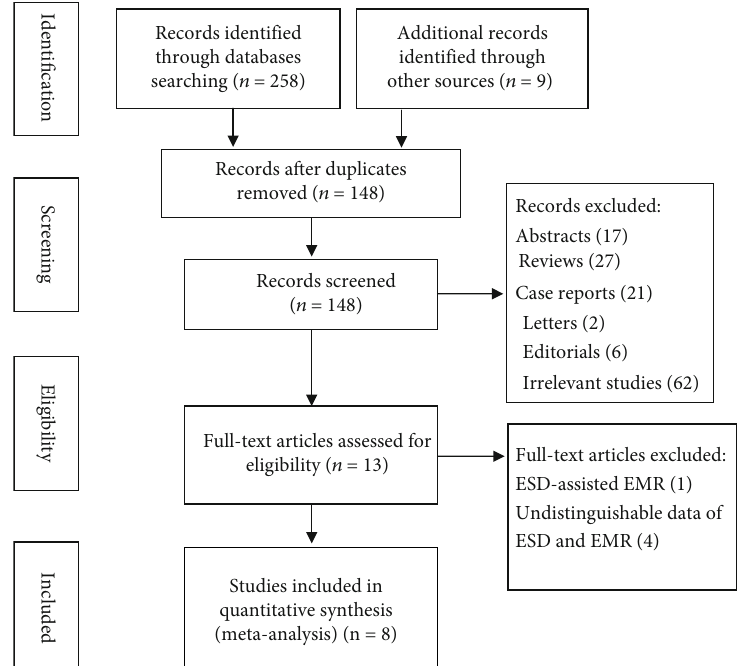
Figure 1: Flow diagram of the studies included in this